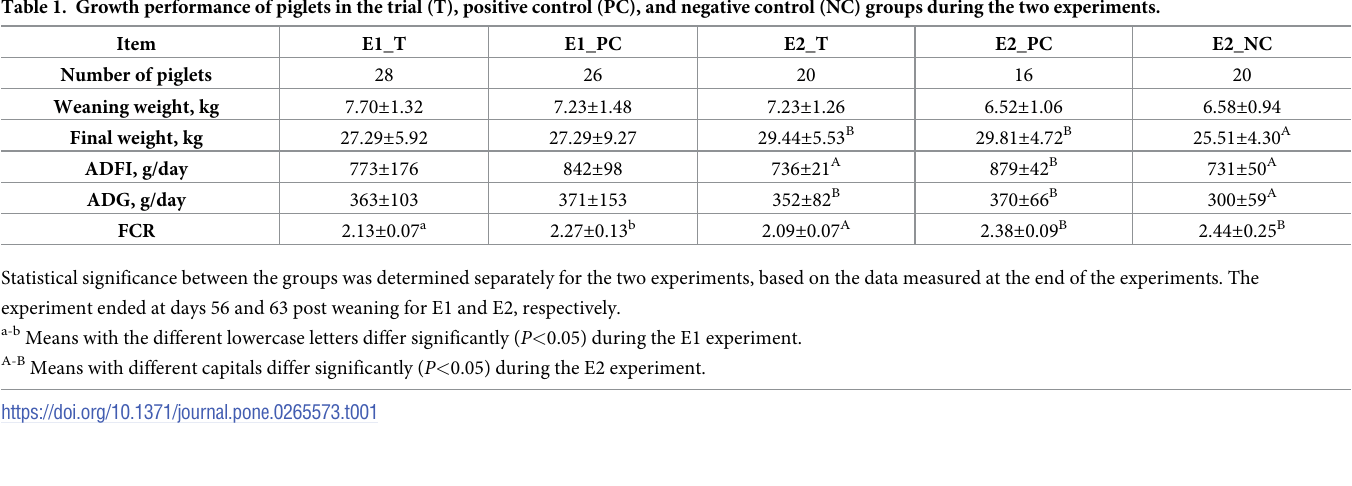
Table 1. Growth performance of piglets in the trial (T), positive control (PC), and negative control (NC) groups during the two experiments. Item